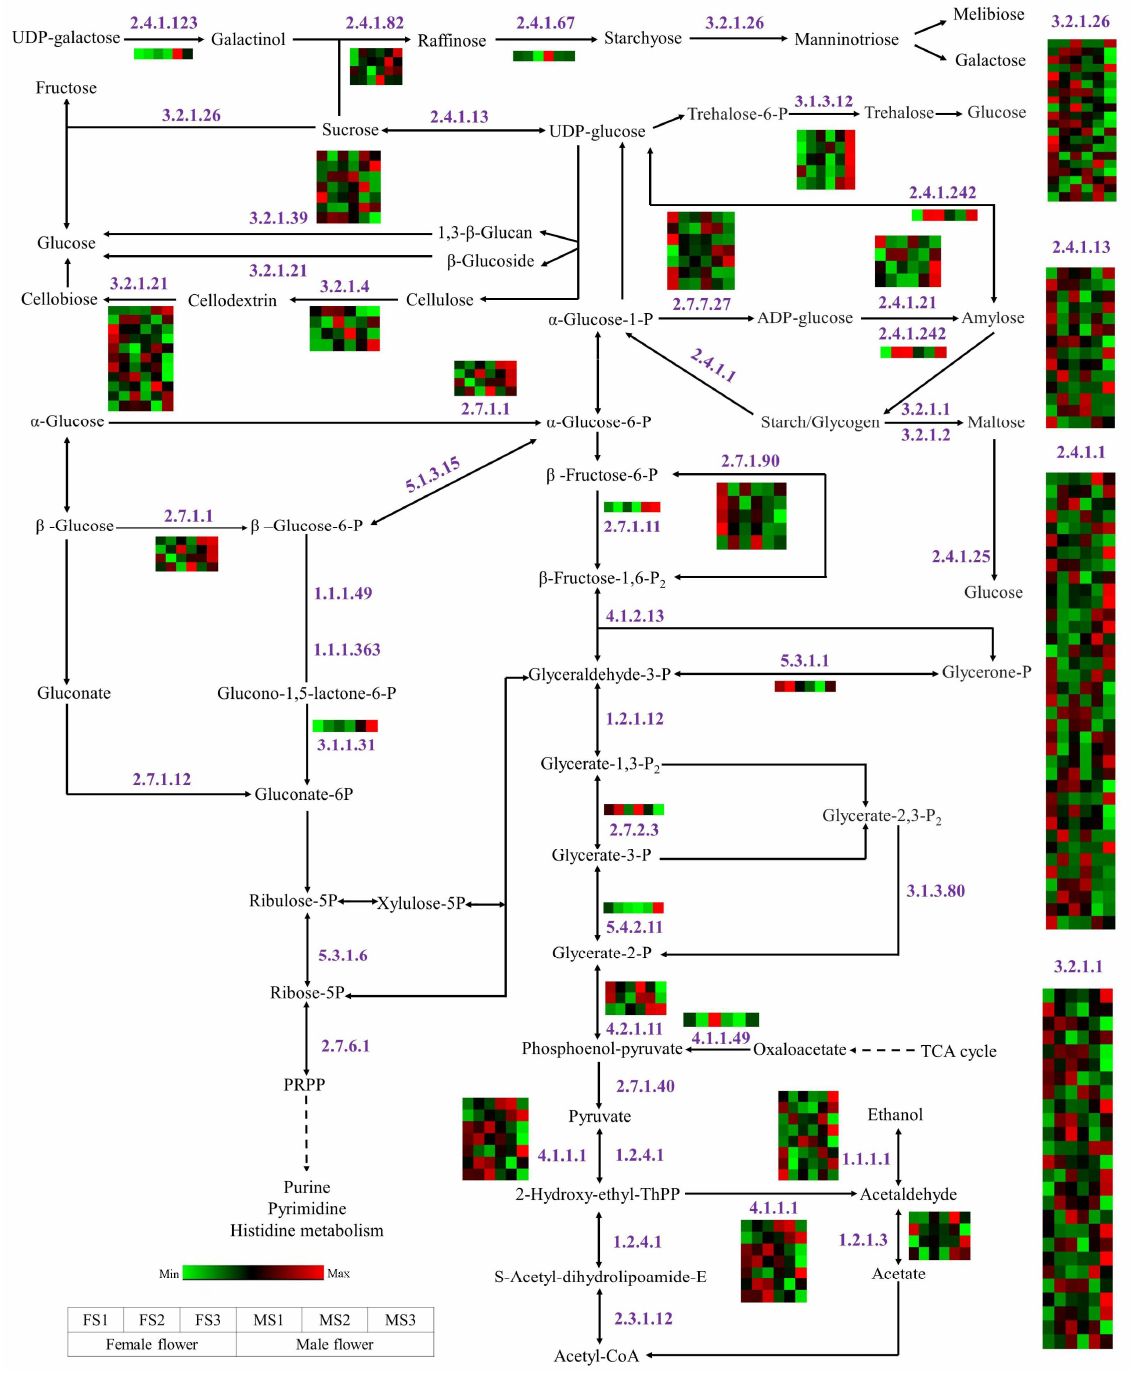
Figure 9. The genes related to energy metabolism during flower development in J. mandshurica . The number next to the arrow indicates the enzyme number. The color scale from Min (green) to